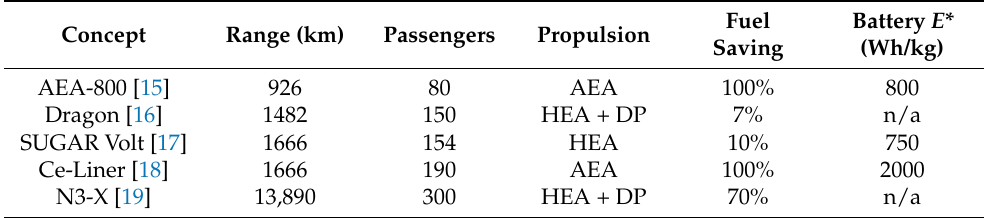
Table 1. Future commercial airliner concepts showing fuel savings relative to a conventional aircraft. This table does not include smaller (typically one to four seat) electric aircraft prototypes or demon- strators, either in development or which have flown. AEA = all-electric aircraft , HEA = hybrid-electric aircraft , DP = distributed